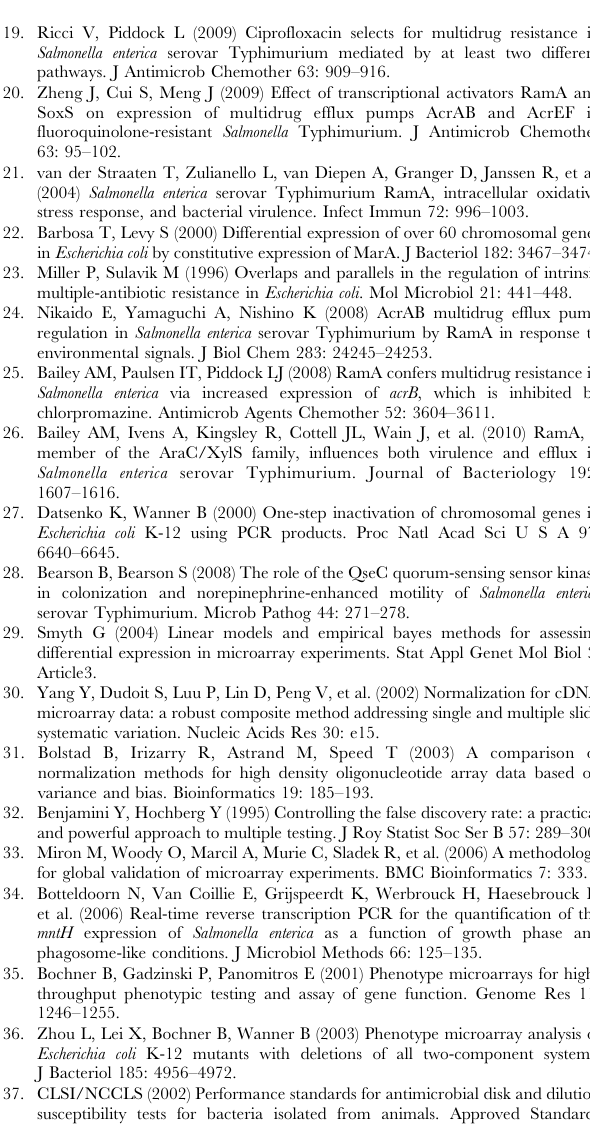
Table S1 Real Time-PCR Primers used in validation of microarray data. Table S2 Compounds with increased susceptibilities greater than or equal to 1.5-fold due to ramA inactivation in comparing S .